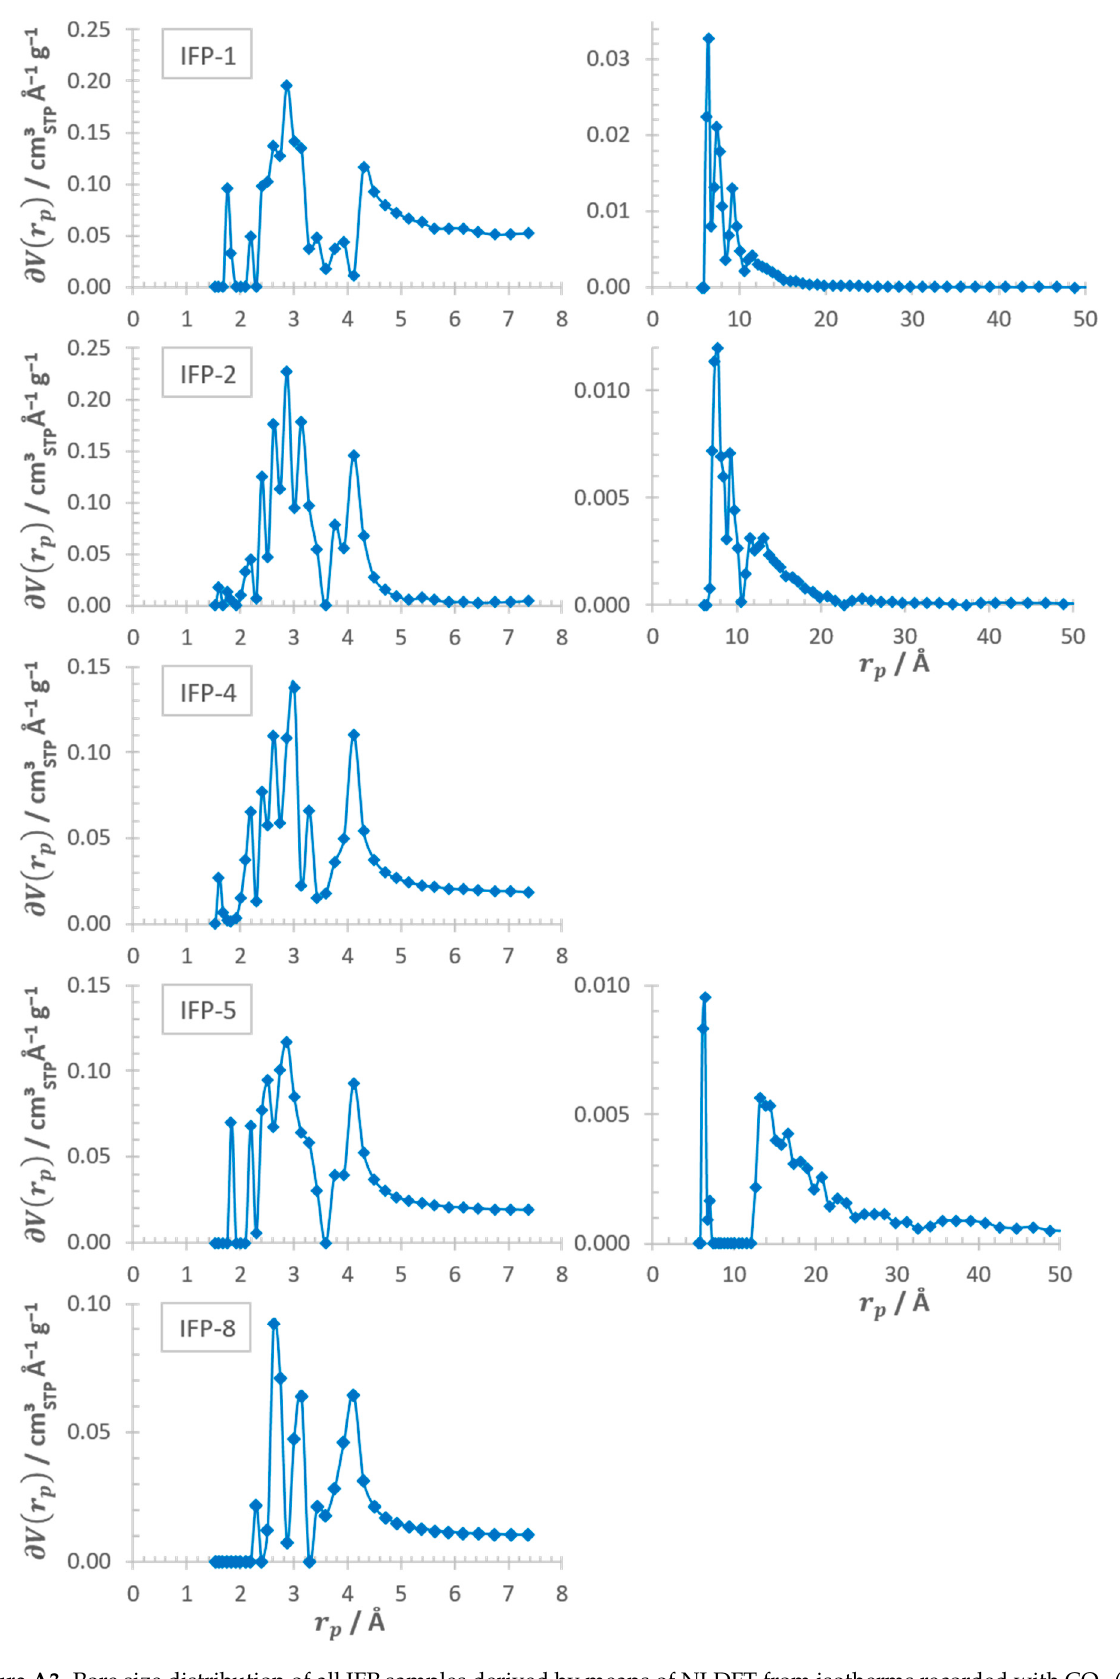
Figure A3. Pore size distribution of all IFP samples derived by means of NLDFT from isotherms recorded with CO 2 ( left ) and N 2 ( right , IFP-4 and -8 are missing because of irrelevance) .